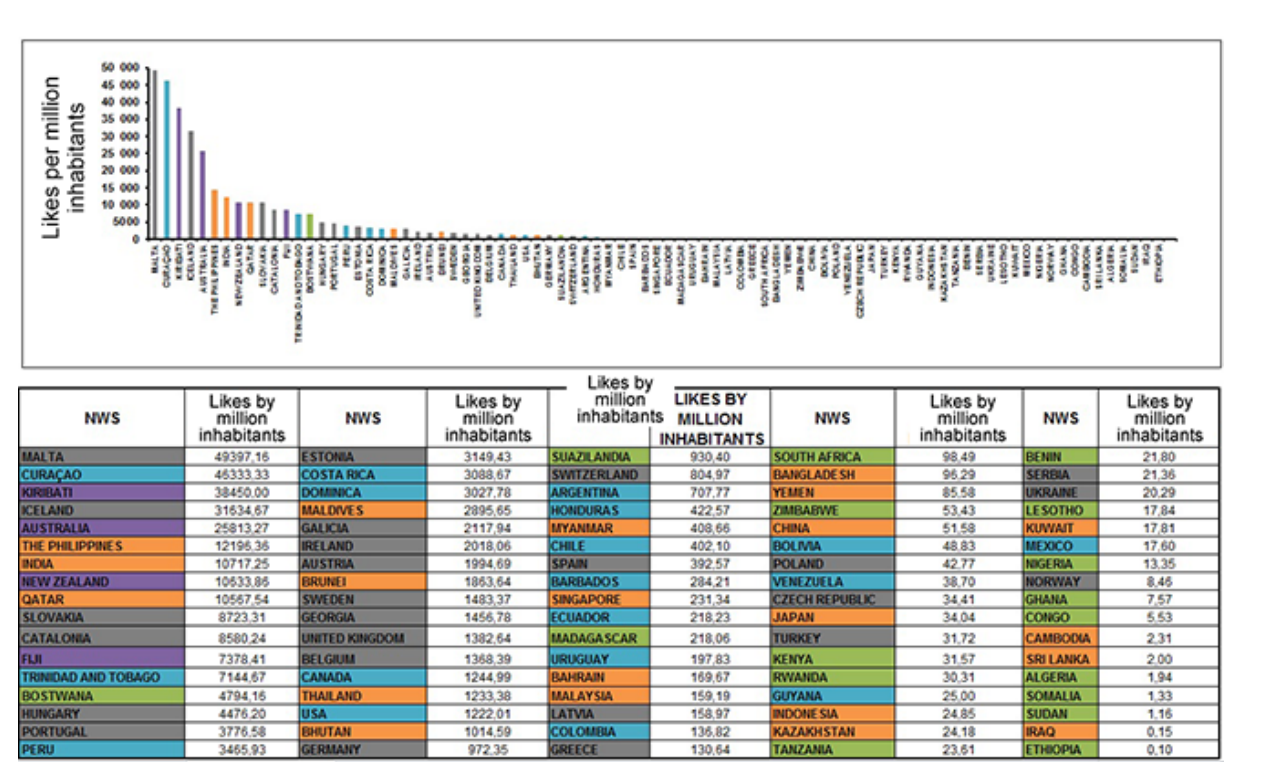
Figure 4. Likes by million inhabitants of NMSs’ Facebook accounts (May